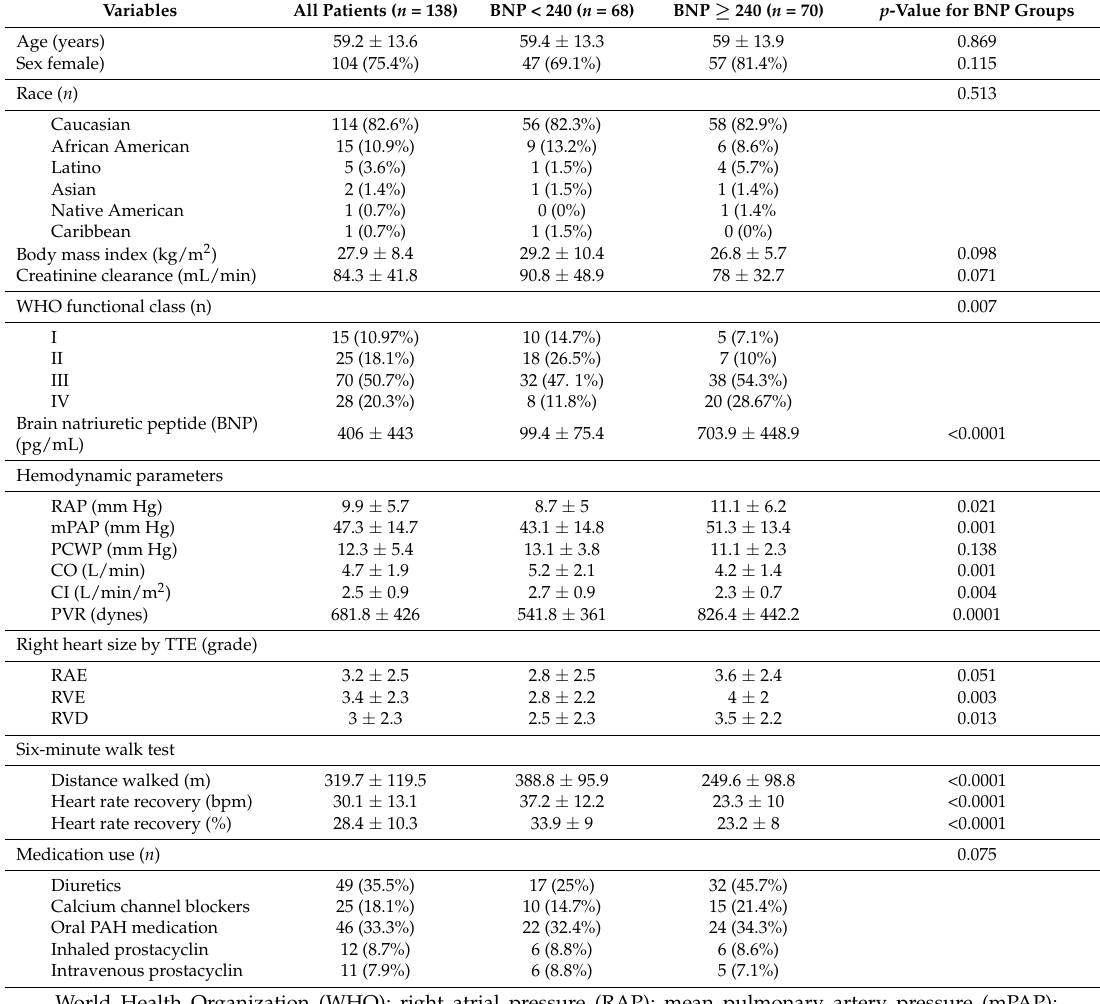
Table 1. Clinical characteristics of the study